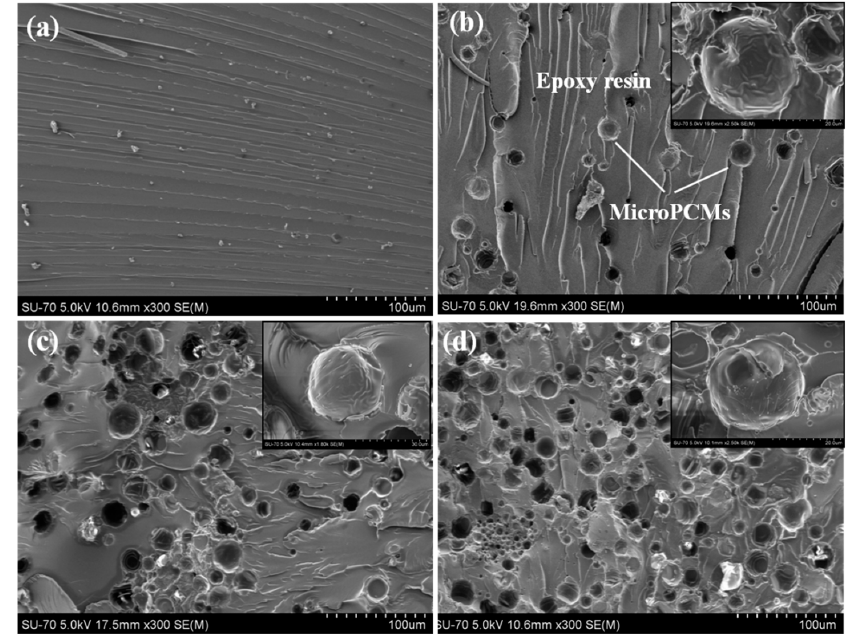
Figure 6. SEM images of MicroPCMs/epoxy composites with MicroPCMs contents of ( a ) 0 wt%, ( b ) 5 wt%, ( c ) 10 wt%, ( d ) 20 wt%, inserted with images with high